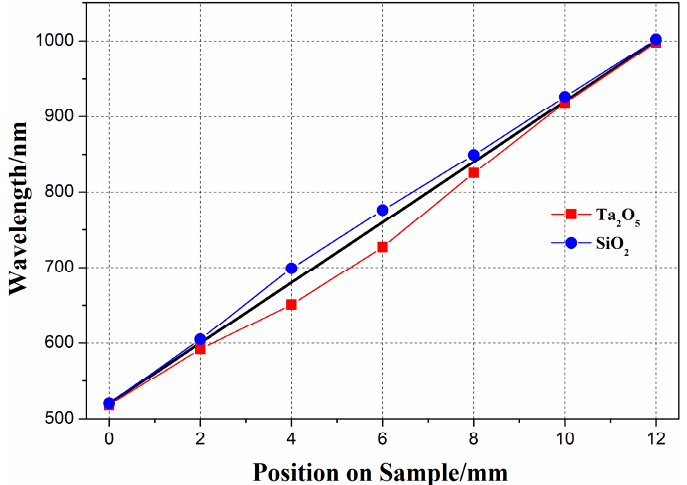
Figure 4. Linear change rate of the thickness of the two materials.